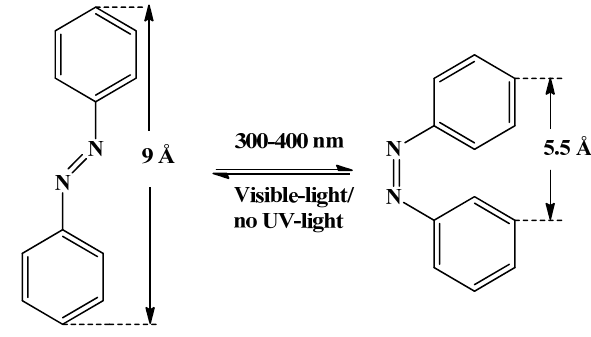
Figure 8. Trans-cis isomerization of